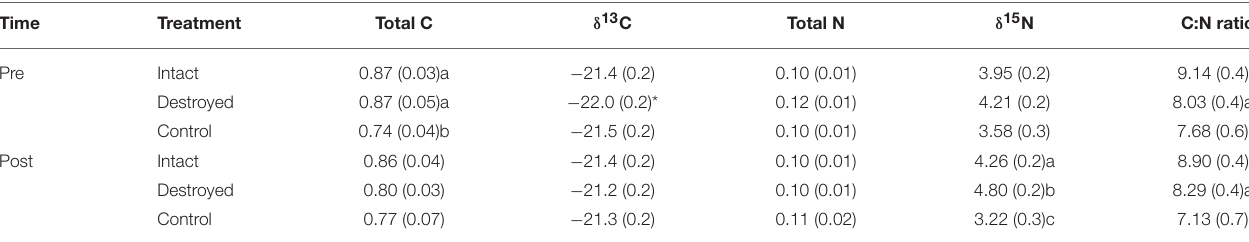
TABLE 2 | Means of soil carbon and nitrogen characteristics for the three studied treatments Pre and Post.